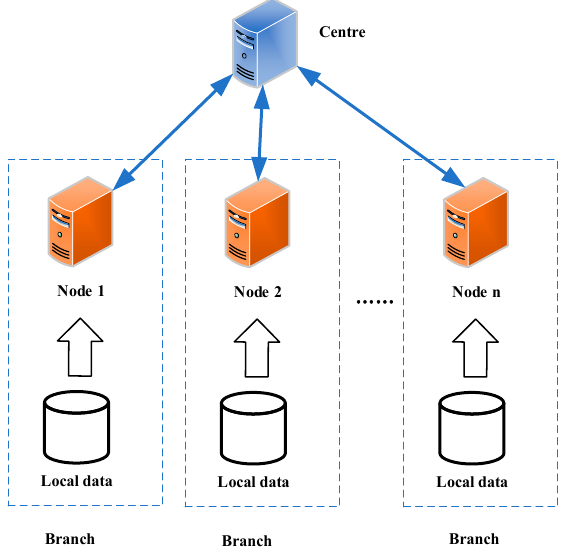
Figure 1. Topology of smart-grid-distributed intrusion detection model.